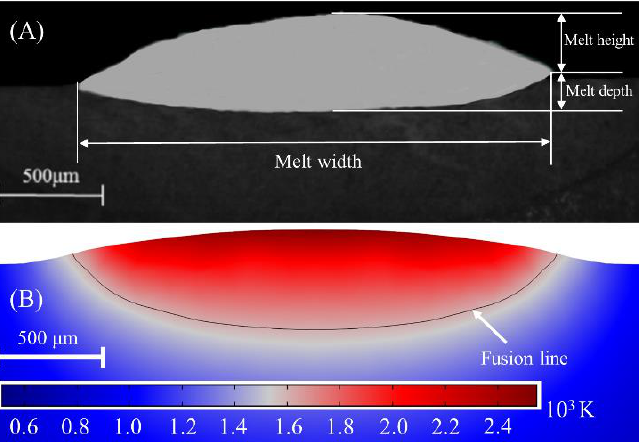
Figure 4. Cross-section of deposited track. ( A ) Experimental result [18]; ( B ) Calculated result. Reprinted with permission from ref. [18]. Copyright 2017 Elsevier.